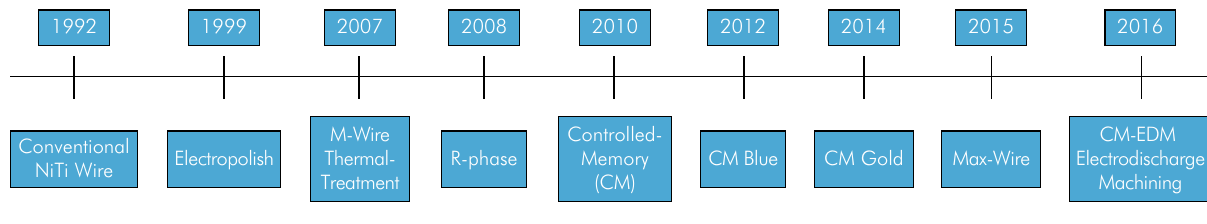
Figure 2. Evolution of NiTi Alloy